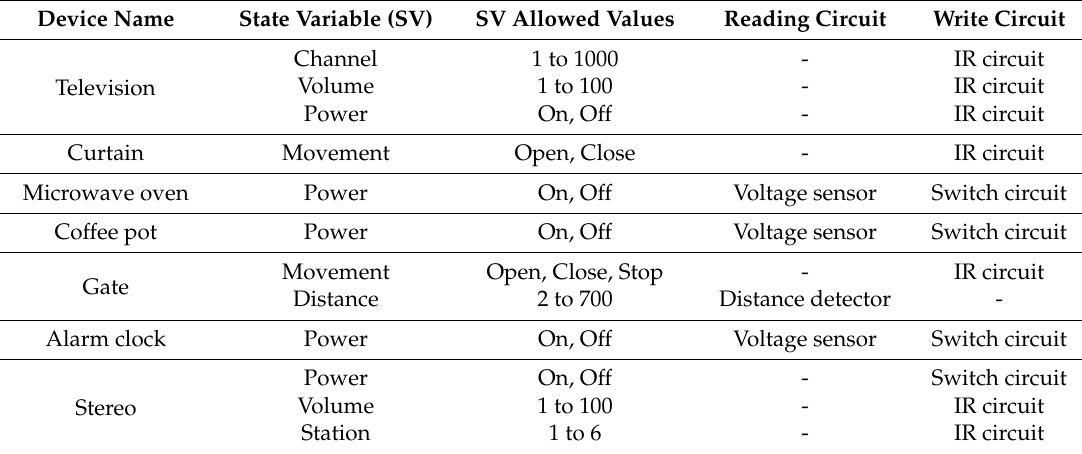
Table 1. Devices of the home automation